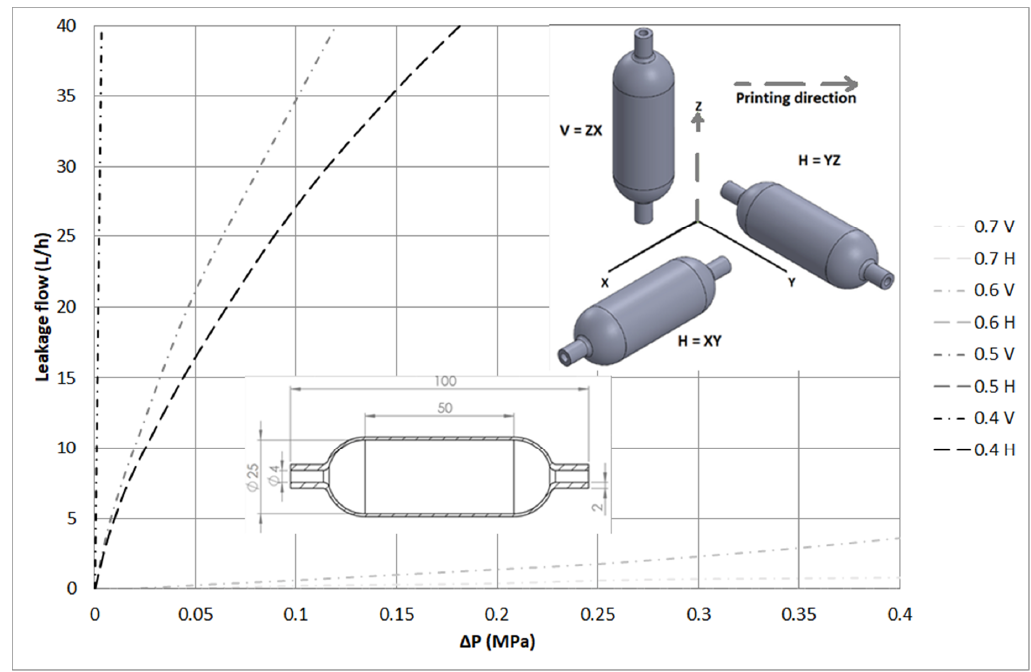
Figure 3. Leakage flow rate and pressure drop for all specimens.